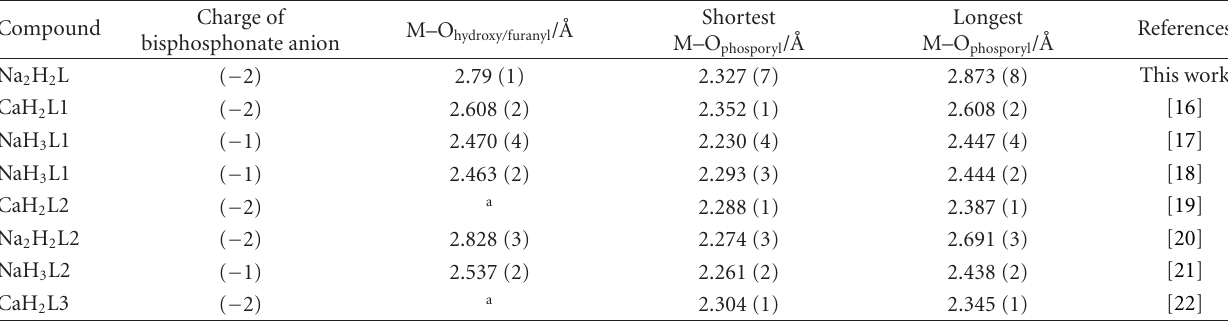
Table 4: Selected bond lengths for Na + and Ca 2+ bisphosphonate complexes. The L, L1, L2, L3 bisphosphonates are according to Scheme 2.